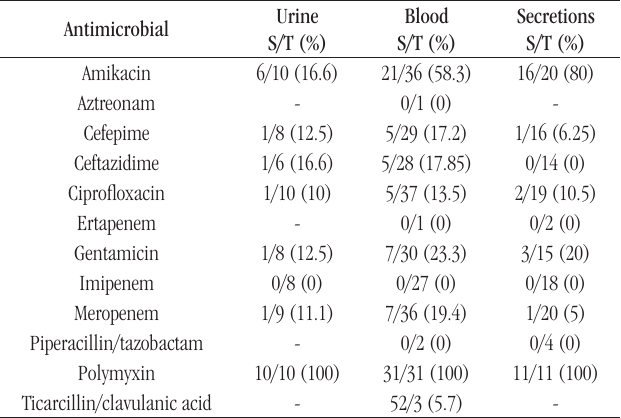
taBLE 3 − Susceptibility profile of Acinetobacter spp. isolated from different clinical specimens in antimicrobial testing Antimicrobial